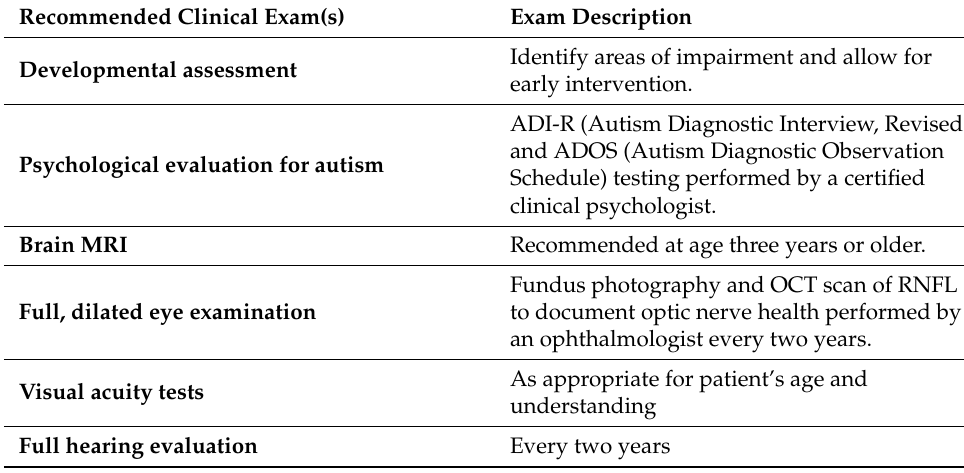
Table 3. Clinical exams recommended for children with BBSOAS. Table showing the main clinical tests for patients with NR2F1 haploinsufficiency. Abbreviations: MRI, magnetic resonance imaging; OCT, optical coherence tomography; RNFL, retinal nerve fiber layer.